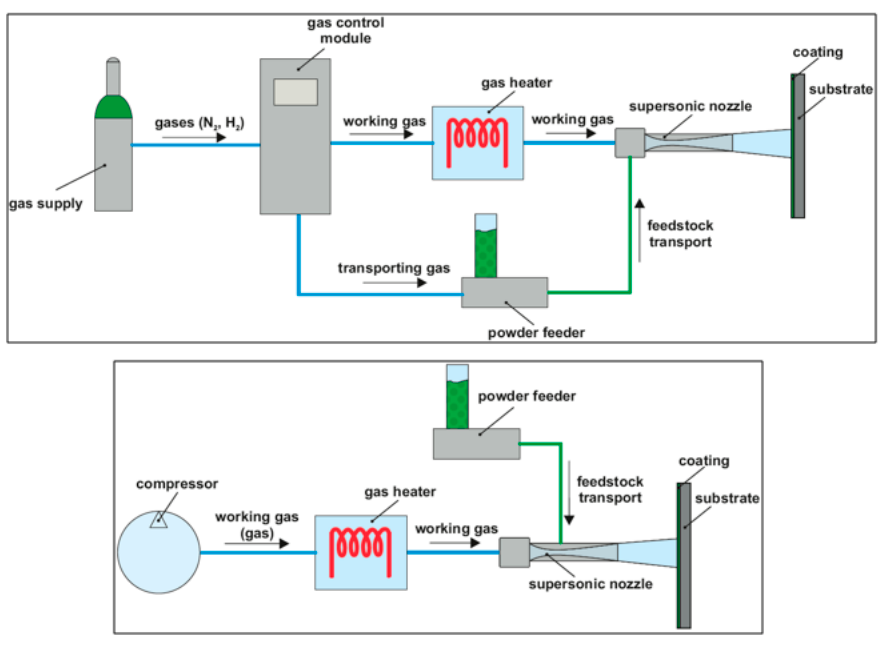
Figure 9. The scheme and principle of high- ( up ) and low-pressure ( down ) cold spray systems.